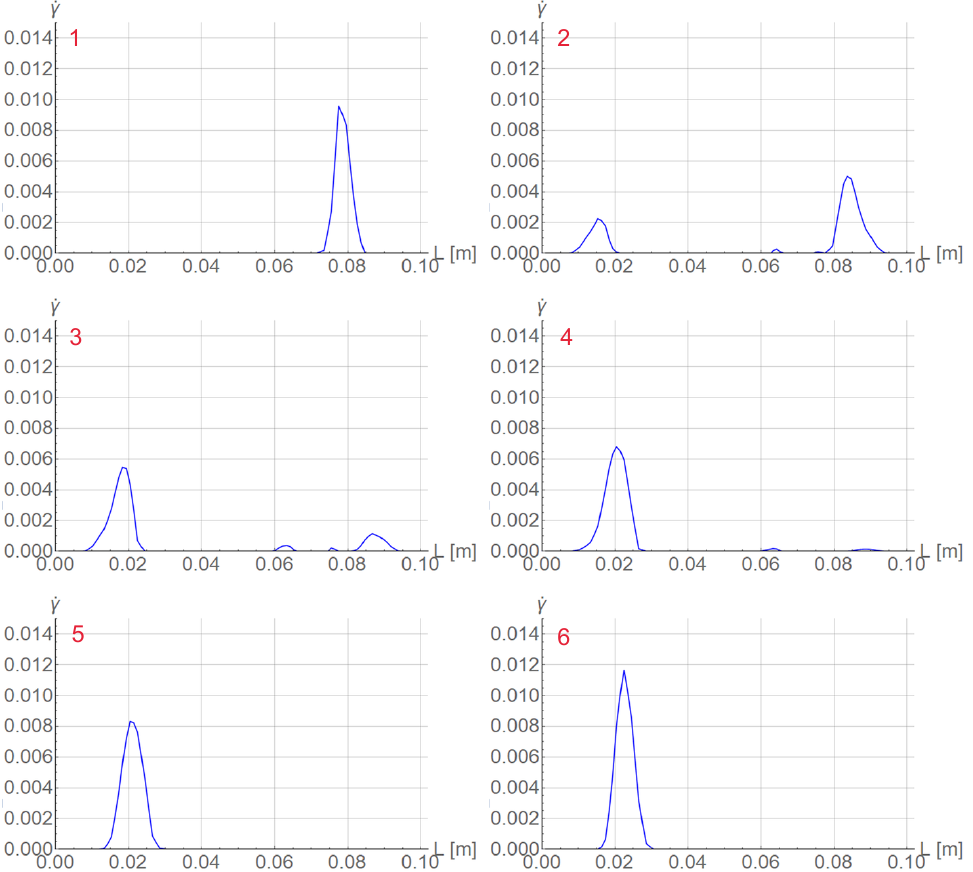
Figure 9. Distributions of ˙ γ along the specimen axis at numbered states for ξ = 40 MPa · s, k = 121 J/(s · K · m) and t 0 = 0.125 s.